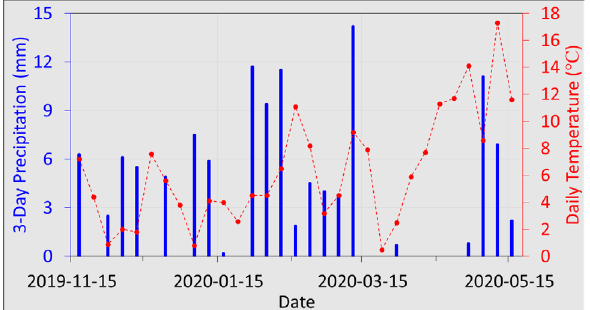
Figure 4. Measurement of precipitation (mm) and temperature (℃) around test grasslands ( Figure 3) during 6 months from weather stations of Germany’s National Meteorological Service.